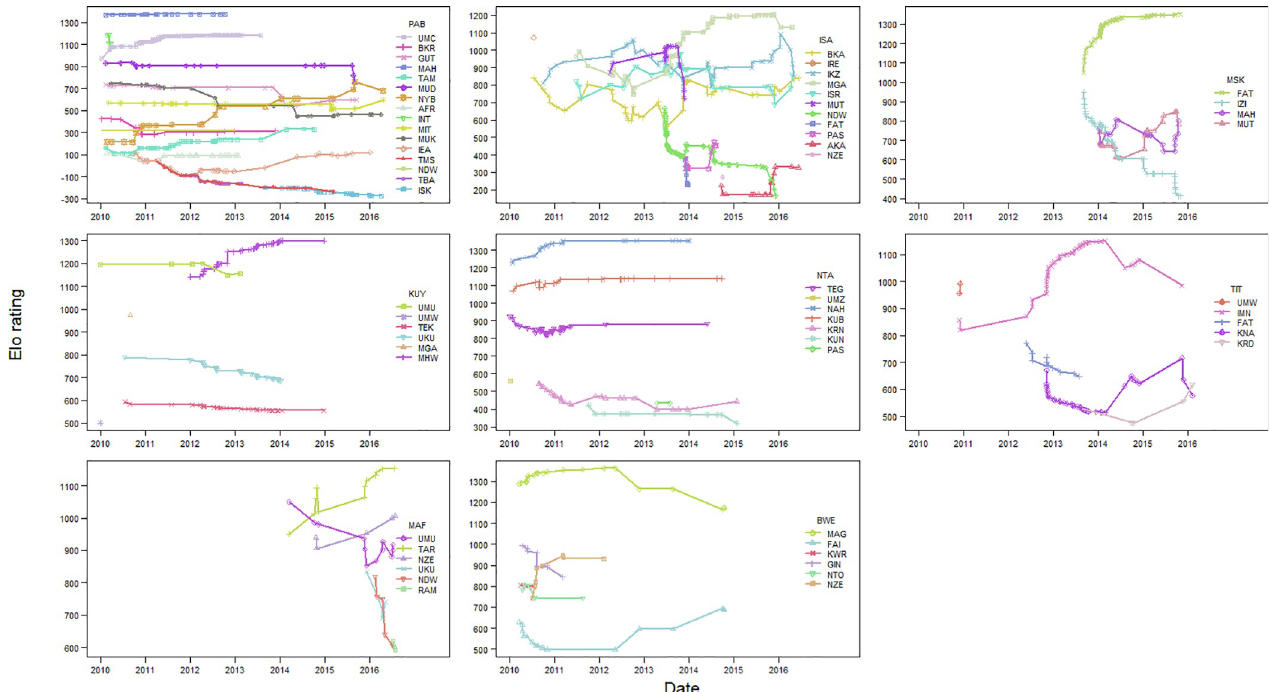
Fig 1. Elo ratings for adult females in eight social groups between January 2010 and July 2016. Elo ratings were calculated using long-term dominance interactions dating back to the date of each group formation (or to 2000 for PAB group). For clarity data are only shown for the period 2010–2016. Each symbol denotes a female and each point represents an interaction between females, with lines between points representing the change in Elo rating for the two interacting females.